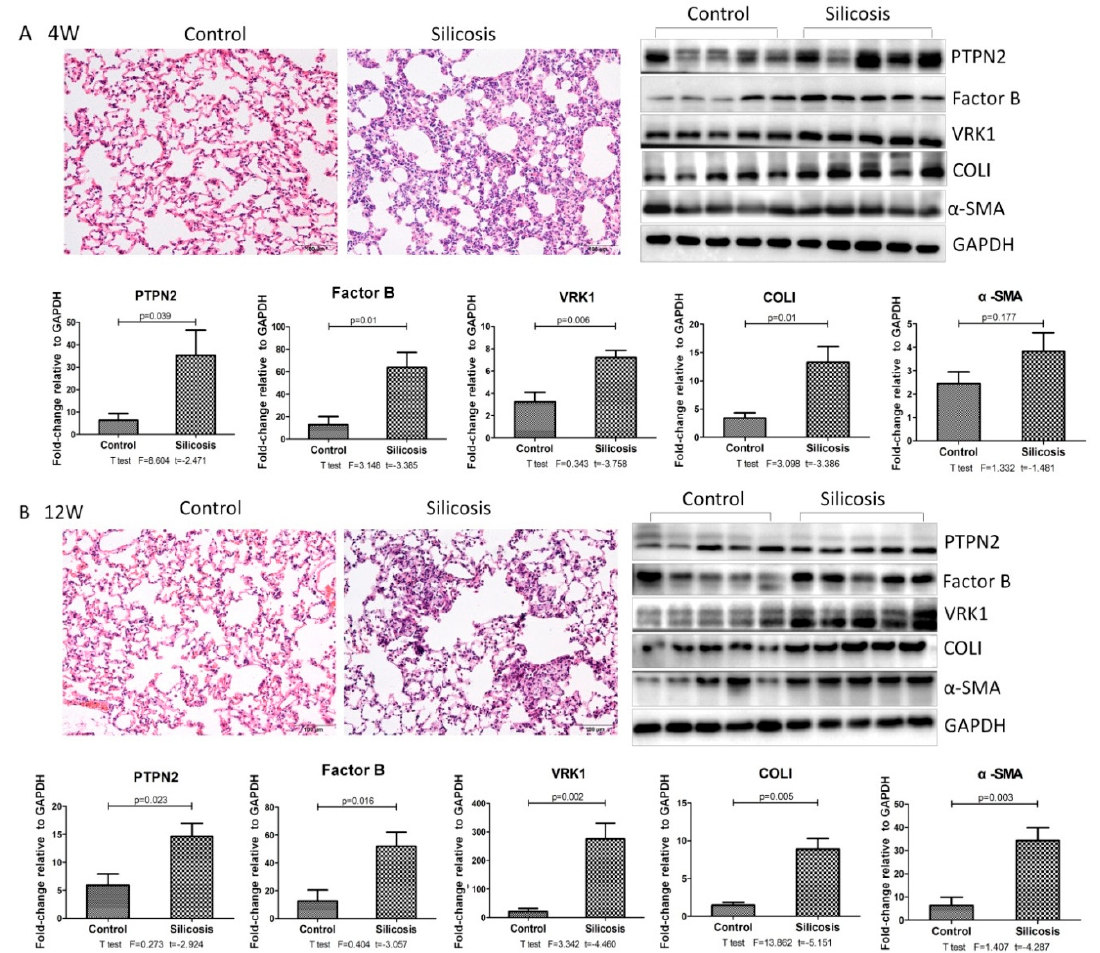
Figure 2. Observation of pathological changes in experimental rat silicosis.( A ) Lung tissue stained with H&E. Scale bars: 100 µ m; Western blot and corresponding densitometry data of the expression levels of PTPN2, factor B, VRK1, Col I, and α -SMA in the lung tissue of the silicosis model after four weeks. ( B ) Lung tissue stained with H&E. Scale bars: 100 µ m; Western blot and corresponding